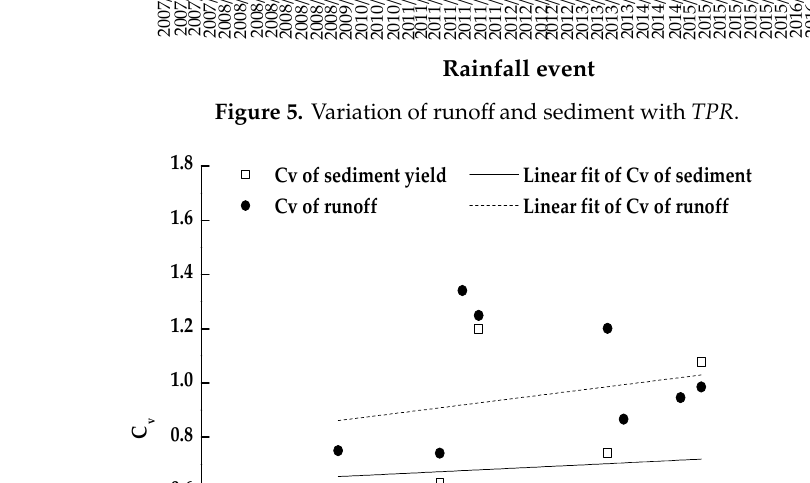
Figure 5. Variation of runoff and sediment with TPR .